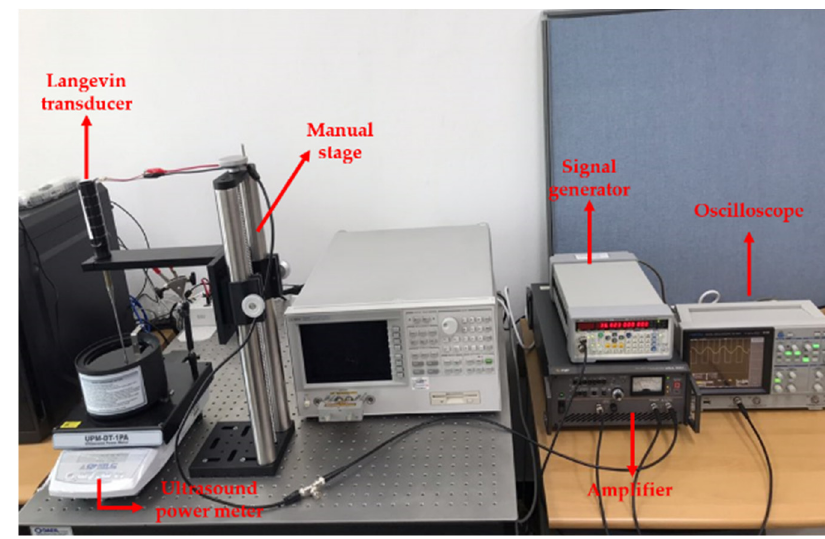
Figure 6. View of power measurement system.